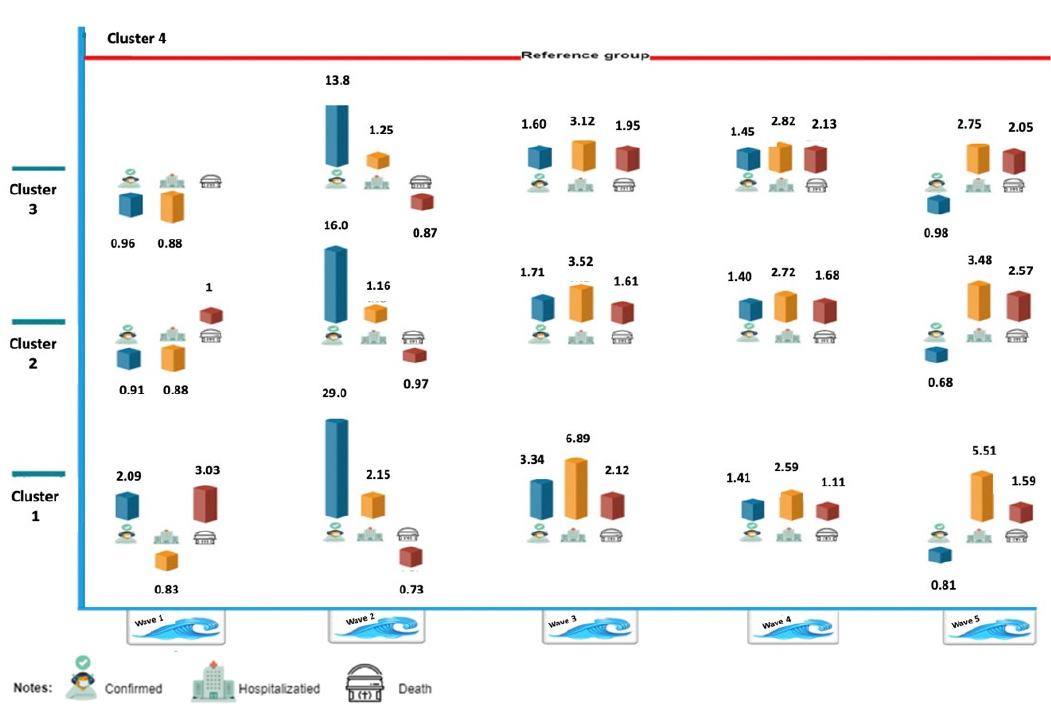
Figure 4. Relative risk between each cluster (1–3) and cluster 4, for each of the variables during the five waves of the pandemic.